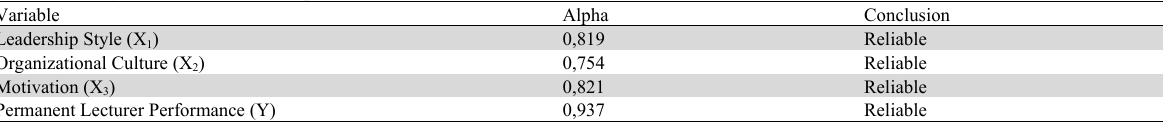
The summary of the Cronbach